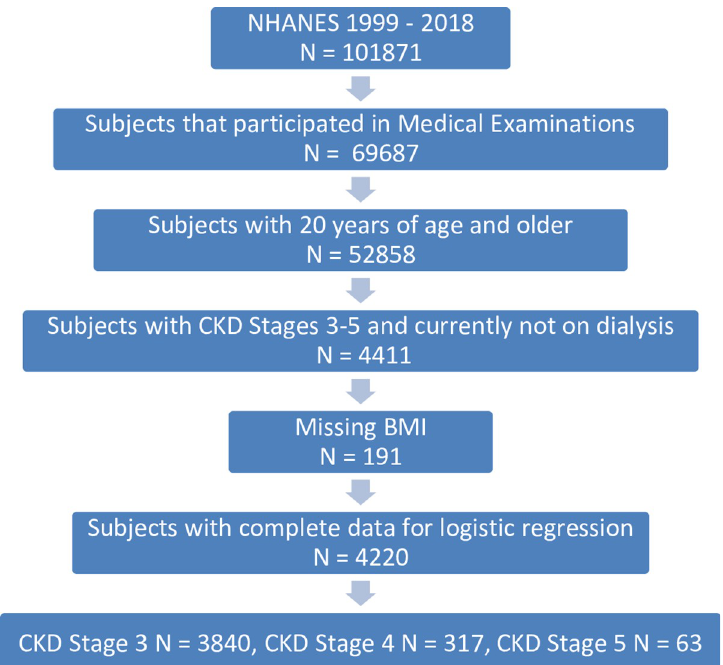
Fig 1. Flow chart of the study